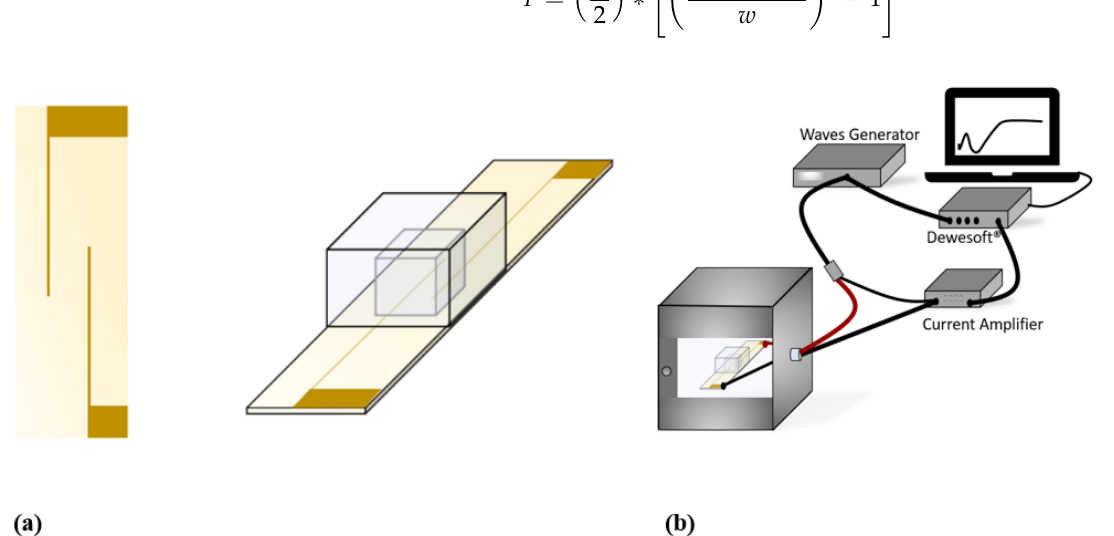
Figure 1. ( a ) Sample holder used for blood impedance-magnitude spectroscopy. ( b ) Complete set-up employed in | Z | measurements.